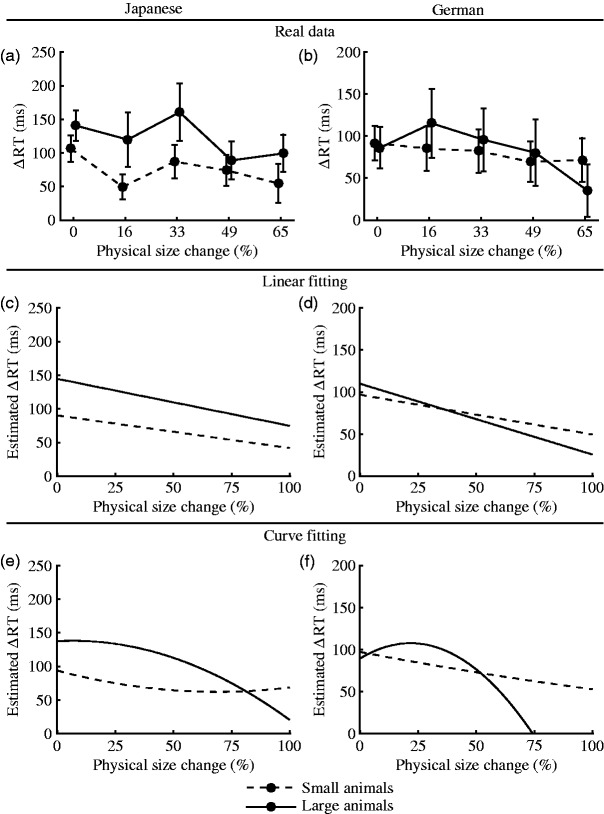
Average ΔRT plotted for each subcategory of visual stimuli
(large and small), shown for (a) Japanese and (b) German
participants. Estimated ΔRTs by a linear fitting method
are shown for (c) Japanese and (d) German participants.
Estimated ΔRTs by a curve fitting method are shown for (e)
Japanese and (f) German participants.RT = response time.